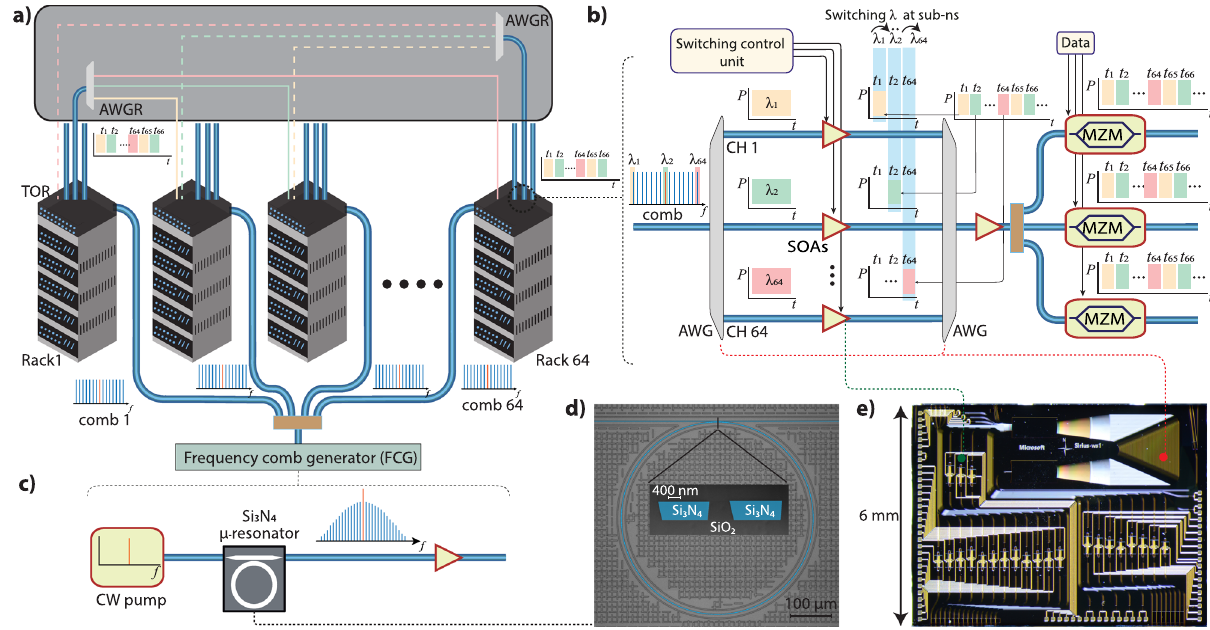
Fig. 1 Concept of optical circuit switching (OCS) using a photonic chip-based Si 3 N 4 soliton microcomb and semiconductor optical ampli fi ers (SOAs). a Interconnection of 64 racks via an arrayed waveguide grating router (AWGR) for implementing fast OCS. In this model, distinct wavelengths are assigned to each rack at each time slot. At each receiver, a 10 – 20 nanosecond (ns) time slot is assigned for each rack on a round-robin basis for data transmission. The switching module is placed on the top of rack (TOR) switch. A single comb source that is post ampli fi ed via cascaded ampli fi ers to attain high optical power per line can be distributed among many racks. The 64 individual combs (comb1, ..., comb 64) split from a central frequency comb generator (FCG) can be distributed across 64 different racks as a multiwavelength laser, making this architecture more power-ef fi cient and fl exible. The multiple data- carrying optical carriers are routed using a passive AWGR to the assigned racks. b Each comb channel is transmitted to SOAs after de-multiplexing, where a control signal (turning on/off current) is applied to switch between the comb channels at sub-ns. The comb channels (10-ns slots) are encoded with data using Mach-Zehnder modulators (MZMs) and transmitted to the relevant racks. The multiple MZMs shown here indicate that this architecture can be scaled further to establish links between more racks. c The multi-wavelength source based on the chip-scale soliton microcomb is generated by pumping with a single laser. Microscope images of a Si 3 N 4 microresonator ( d ) and a photonic chip ( e ) containing an AWG and SOAs. The inset in ( d ) shows a false color SEM image of a Si 3 N 4 microresonator ’ s coupling